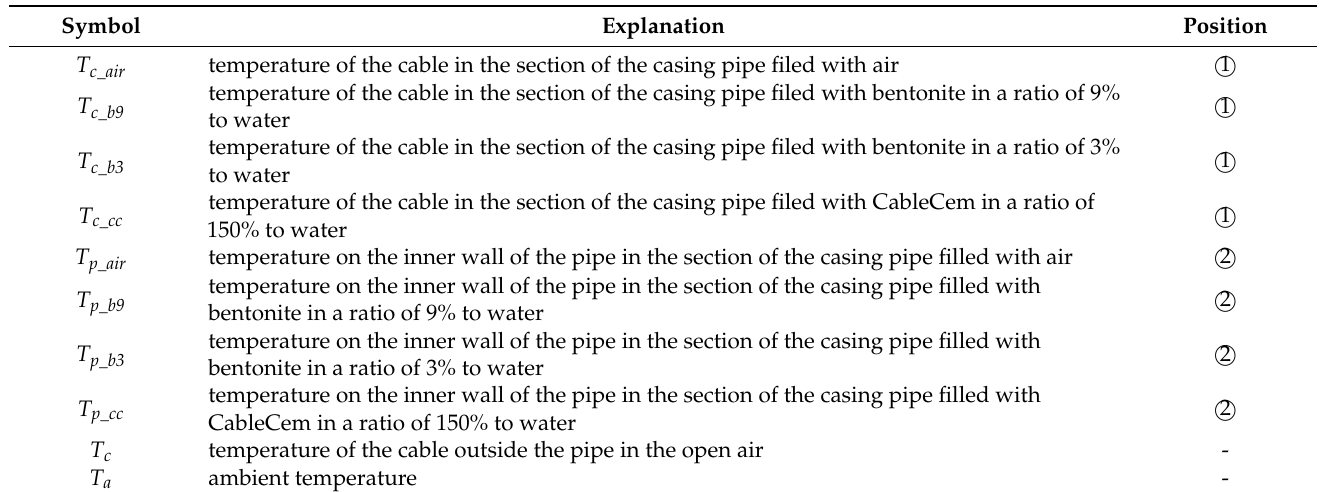
Table A2. A list of symbols used in the graphs in Figures 5–8 with explanation and position in the casing pipe (Figure